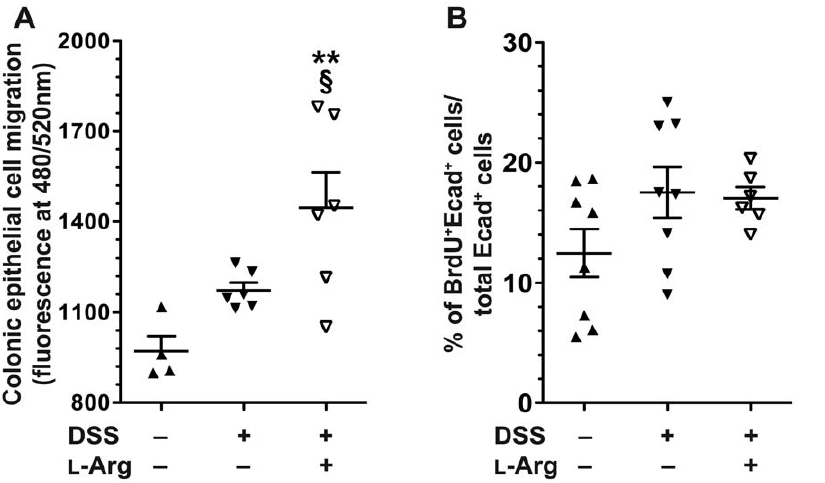
Figure 9. Epithelial cell migration but not proliferation is altered in DSS colitis ± L-Arg. Mice received 4% DSS 6 1% L-Arg in the drinking water as in Figures 3–8. On the day of sacrifice, colons were removed, and epithelial cells were isolated as described in the Methods. (A) Migration assay, performed on freshly isolated CECs, as described in the Methods. (B) On the day of sacrifice, mice were given an i.p. injection of BrdU, CECs were isolated, and stained for BrdU and E-cadherin as described in the Methods. Double-positive cells were detected by flow cytometry. n =4–8 for controls, n =6–8 for treatments. ** p , 0.01 vs. control. 1 p , 0.05 vs. DSS.